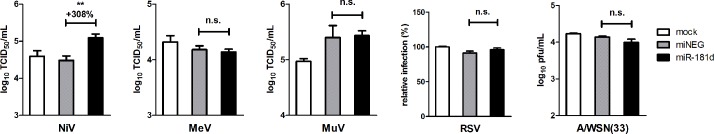
miR-181d promotes henipavirus infection specifically.Infectivity assays were applied to assess changes in virus production or virus infection of HeLa cells infected with NiV, MeV, MuV, RSV or influenza A/WSN/33 virus for 24 h. Cells were previously transfected with miR-181d or negative control agonists (miNEG) for 72 h. **p≤0.01; n.s. not significant.